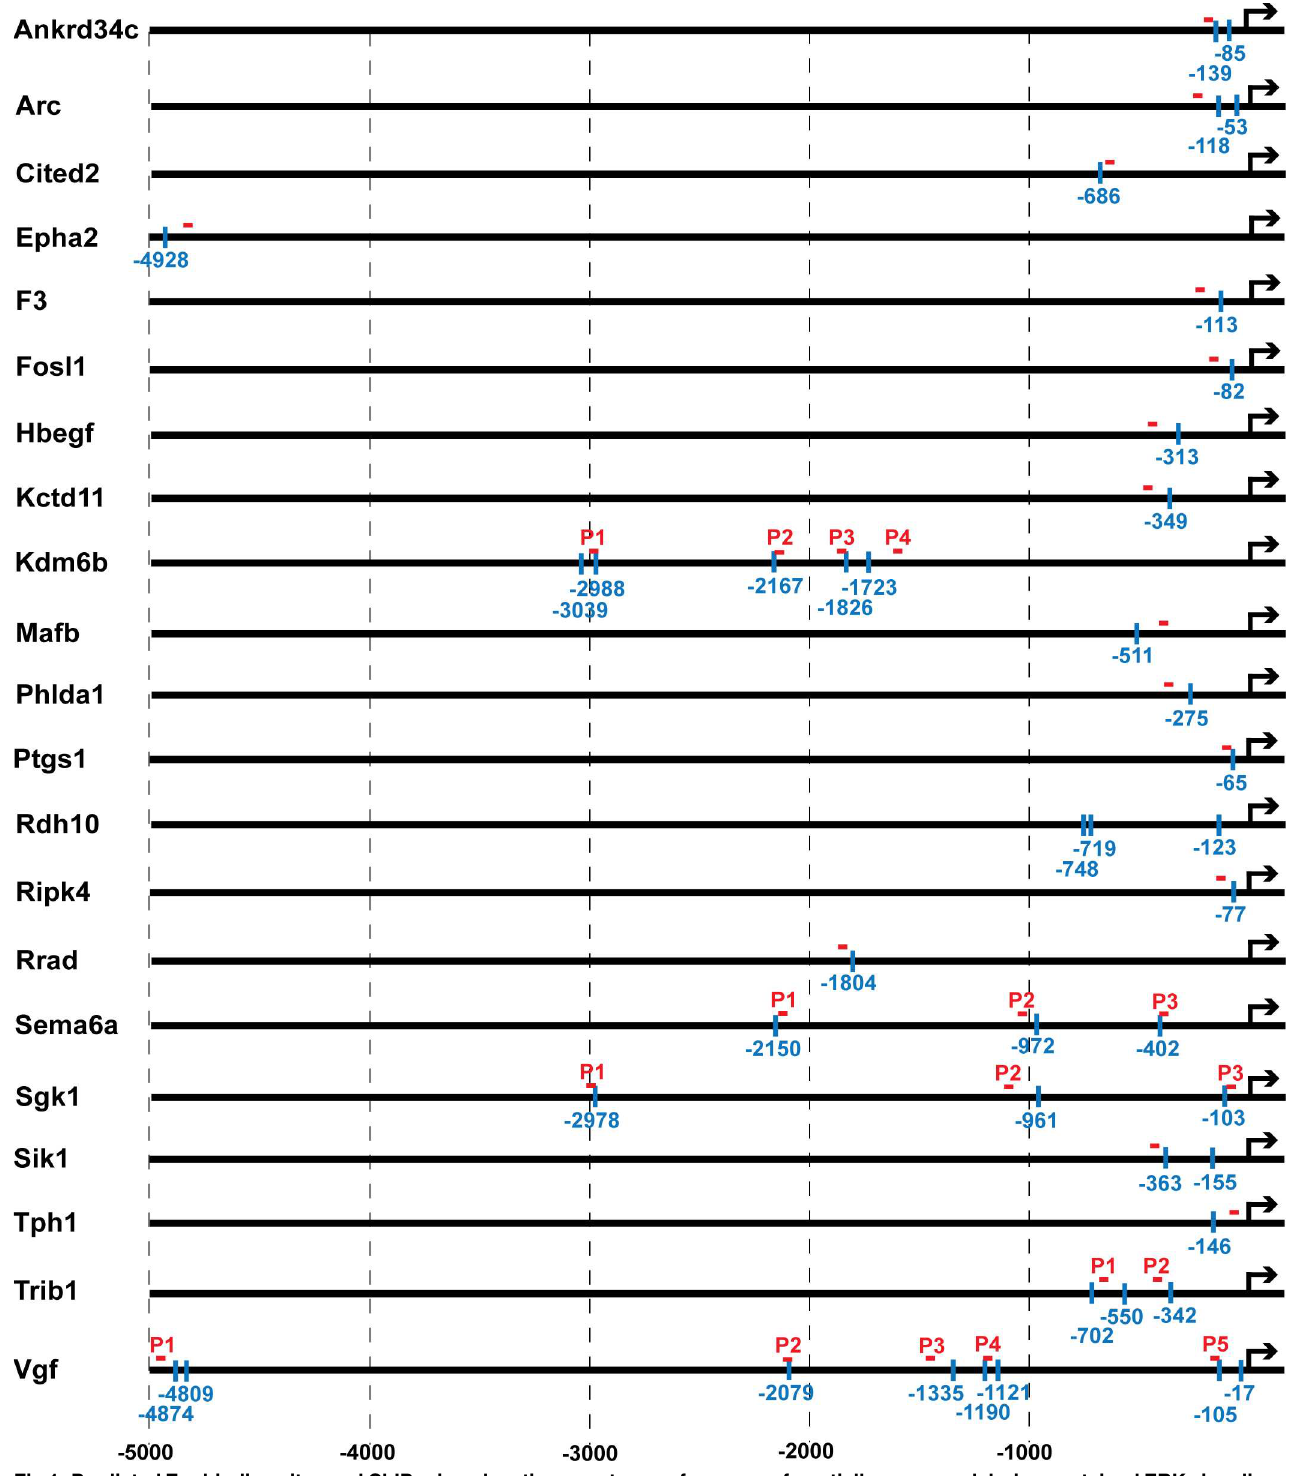
Fig 1. Predicted Egr binding sites and ChIP primer locations upstream of genes preferentially expressedduring sustained ERK signaling in response to NGF. Of the 69 genesthat Mullenbrock et al. (2011) determined are preferentially expressedduringsustainedERK signalingin response to NGF, 21 containedputative Egr bindingsites within 5 kb upstream of their transcriptionstart site (TSS). The locationsof each Egr bindingsite are denotedby the vertical blue lines. The red horizontal lines denote the relativelocationsof primer sets used for real time PCR to